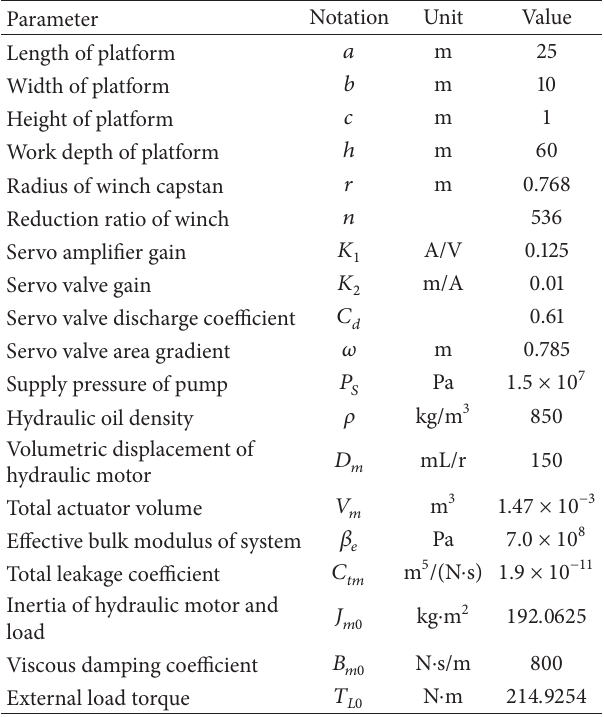
Table 1: Parameters of the platform and hydraulic winch.